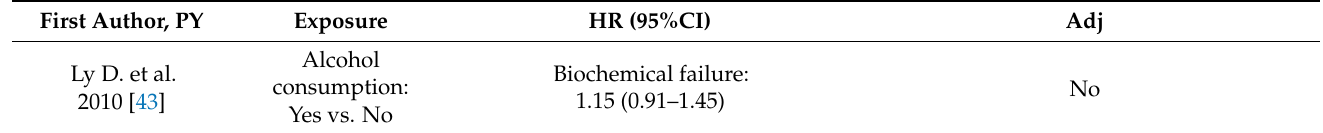
Table 4. Summary results of the studies included in the review that reported on the association between alcohol intake and clinical surrogates of survival of prostate cancer